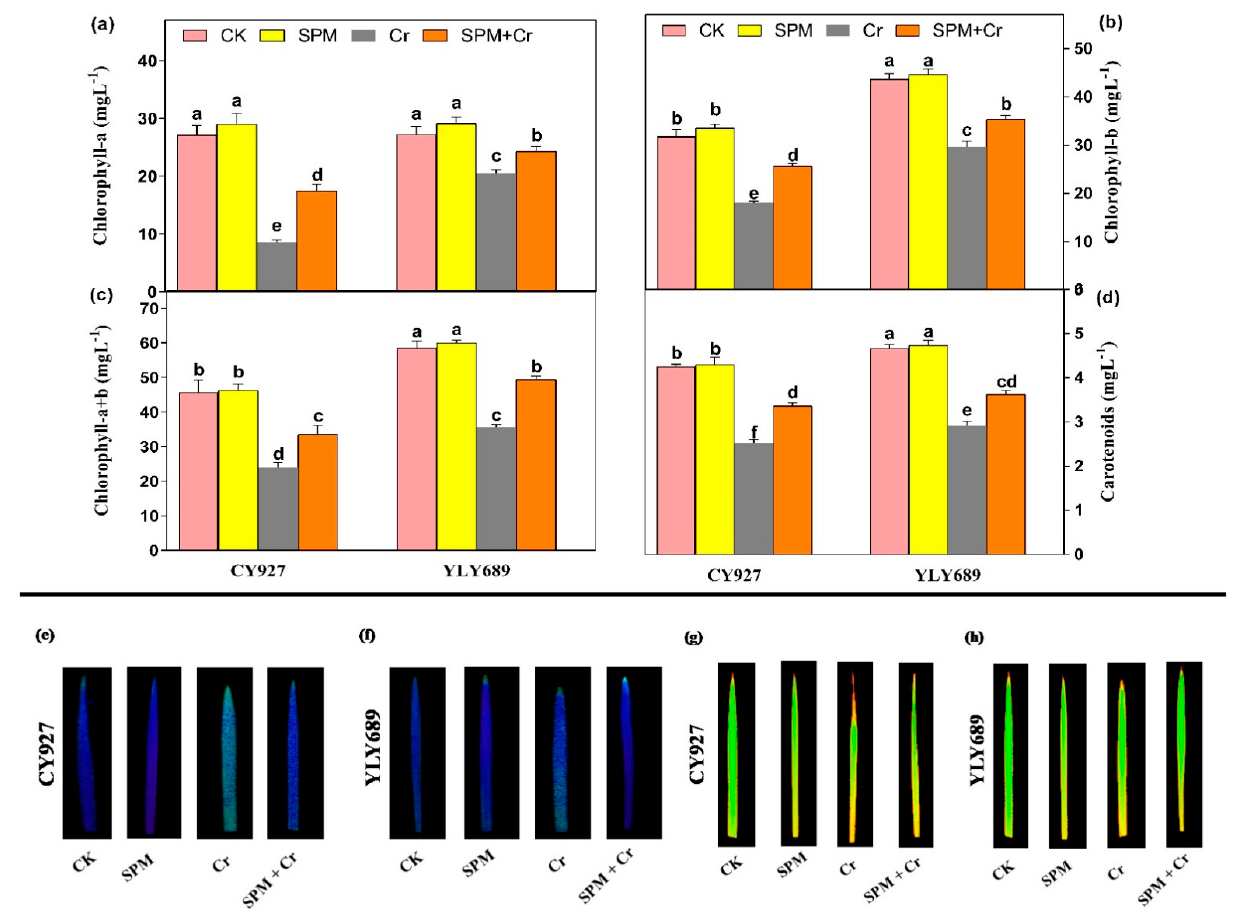
Figure 1. Effects of seed primed SPM on photosynthetic pigments ( a ) chlorophyll–a, ( b ) chlorophyll–b, ( c ) total chlorophyll–(a + b), and ( d ) carotenoids, ( e , f ) Fv / Fm levels in the leaves of two rice cultivars CY927 and YLY689, respectively and ( g , h ) Fm levels in the leaves of two rice cultivars CY927 and YLY689, correspondingly under chromium (Cr) stress. Values are mean ± SE of three independent replicates and different letters (a–f) above bars show a significant difference between treatments by LSD test at p < 0.05.